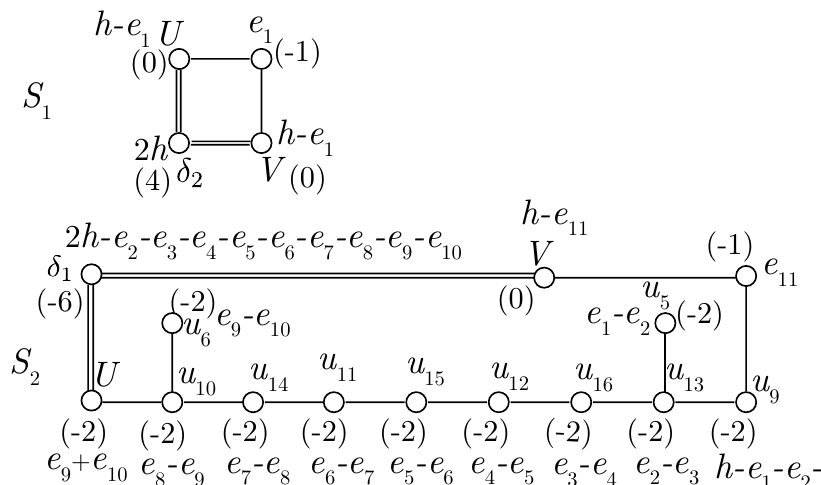
Figure 23 . The con(cid:12)guration of curves on S 1 and S 2 in the geometry that has M = 11 for the D 10 (cid:0) I 1 collision. The number in the bracket denotes the self-intersection number of the curve. The letter denotes an intersection curve with the corresponding